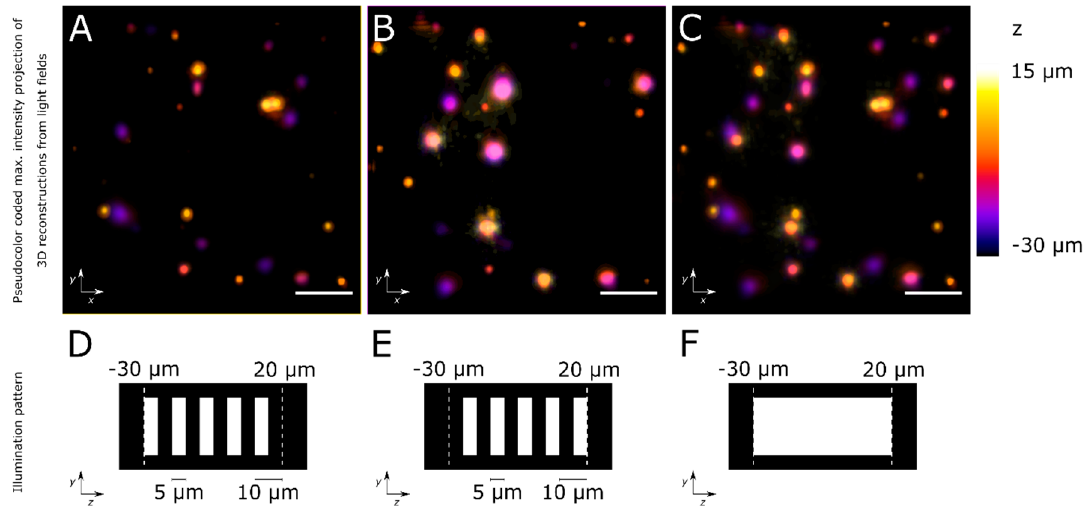
Figure 18. Reconstructions of light fields of 6 μ m fluorescent beads in agar. ( A ) and ( B ) Reconstructions of light fields from complementarily illuminated portions of the sample volume. (C) Reconstruction of the light field from the volume under bright field illumination. ( D , E ), and ( F ) Profiles of illumination patterns for ( A , B ), and ( C ), respectively. In ( D ) and ( E ), sets of 5 μ m wide light sheets provide optical sectioning of the volume. Scalebars 50 μ m.